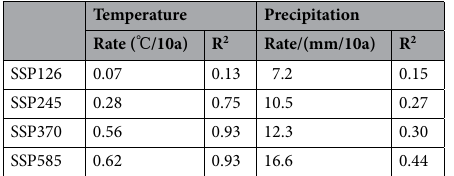
Table 9. The rates of temperature and precipitation at QTP in the four